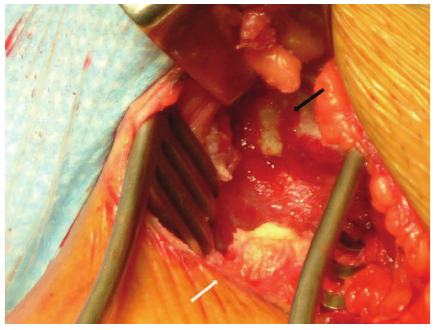
Figure 2: A bare area (black arrow) on the pubic symphysis where the avulsed adductor longus tendon (white arrow) was previously attached.